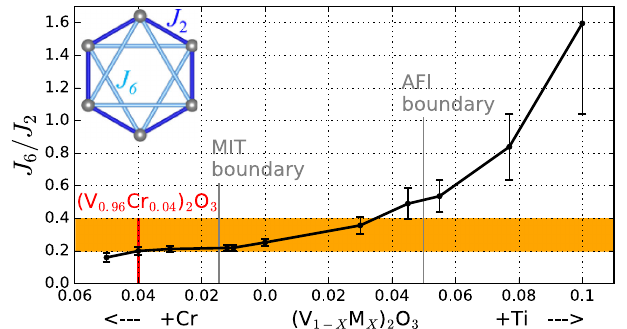
FIG. 5. The ratio of the in-plane honeycomb lattice next- nearest- and nearest-neighbor exchange interaction values, J 6 =J 2 , throughout the phase diagram [Fig. 1(a)] of V 2 O 3 obtained from DFT calculations. The shaded orange region indicates the theoretically predicted range of frustrated inter- actions [68]. It is clear that changes in the crystal structure induced from Cr doping have only minor effects on J 6 =J 2 , as can also been seen in Table II.